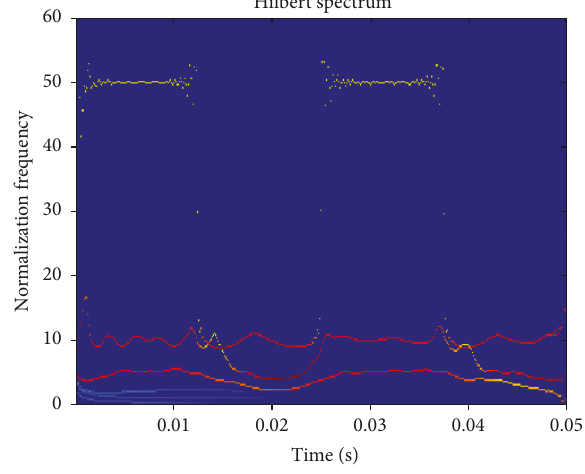
Figure 4: Hilbert spectrum of